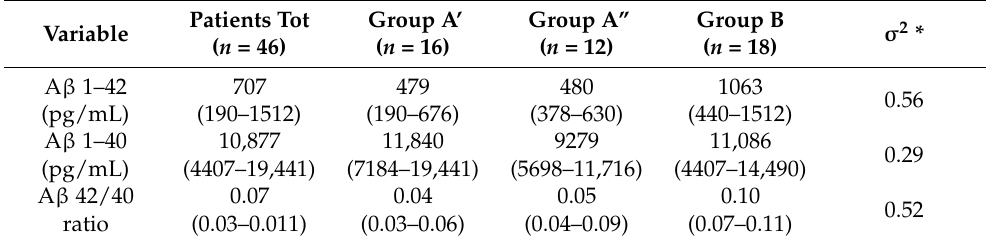
Table 3. Average values recorded for each variable, A β 1–42, A β 1–40 and A β 42/40 ratio. The minimum and maximum values are shown in parentheses; σ 2 is the variance of the values according to “one-way ANOVA”.